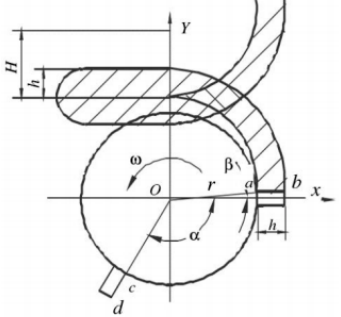
7 of 19 Figure 7. Structure diagram of feeding device of hairy vetch harvester. 1, Bevel gear transmission case; 2, Bearing chamber; 3, Vertical drum; 4, Multi-gear transmission box; 5, Cutting device; 6, Spi- ral conveyor; 7, Frame. 3.2. Design of Key Components 3.2.1. Design of Cutting Device